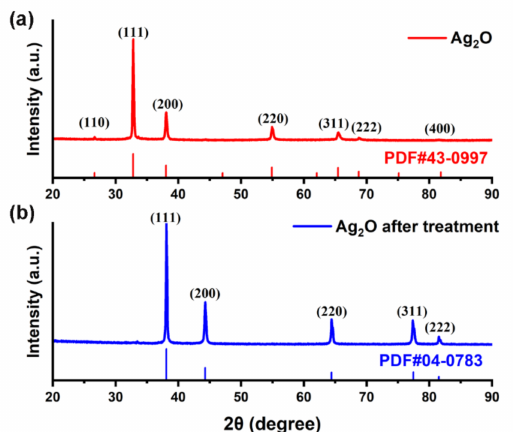
Figure 3. The XRD patterns of the following: ( a ) Ag 2 O powder and ( b ) Ag 2 O powder after the treatment in Pt-catalyzed formic acid vapor at 50 ◦ C for 5